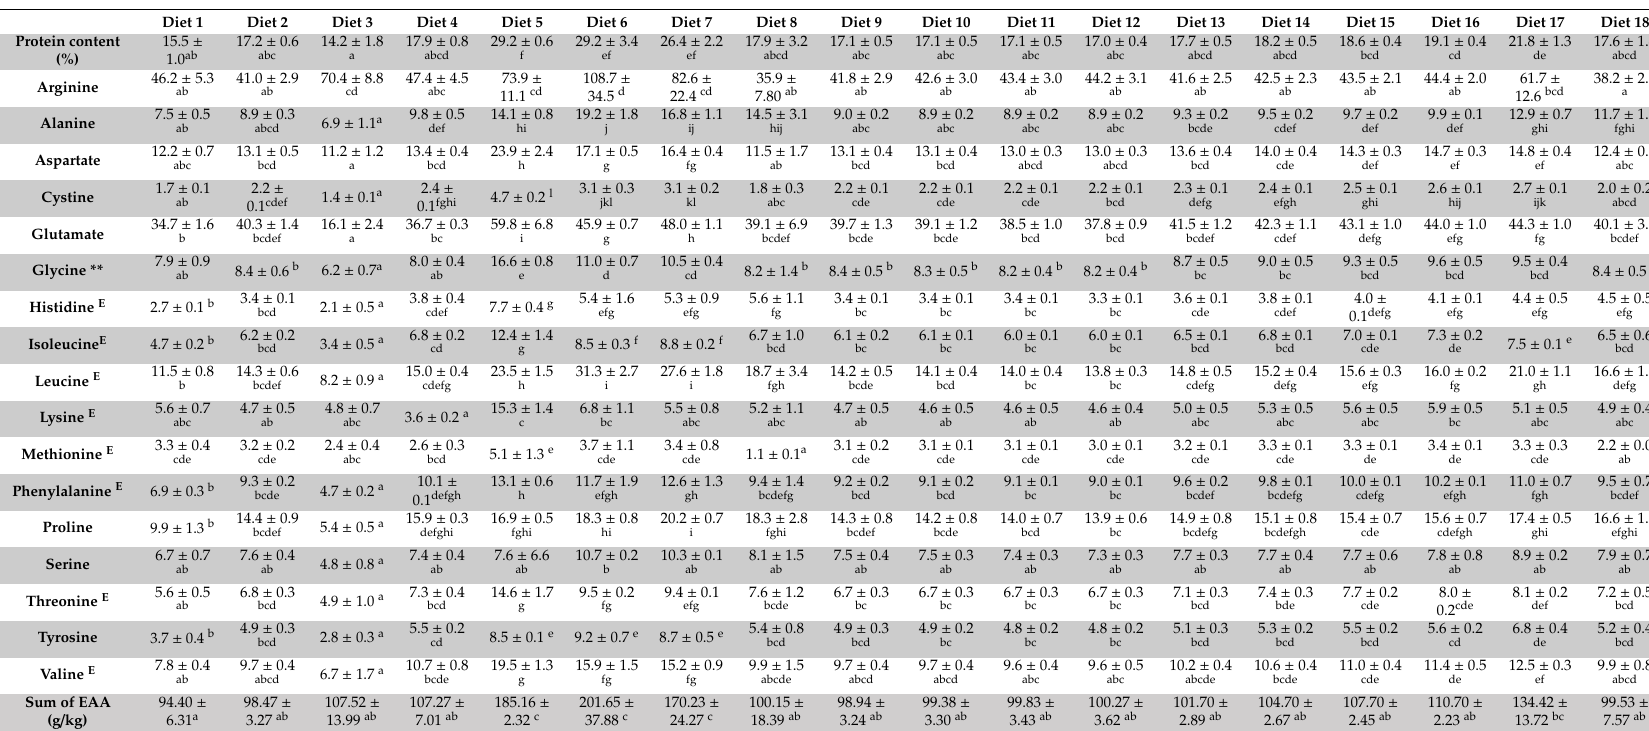
Table A2. Protein content (%), amino acid profile (g / kg) and sum of essential amino acids (g / kg) of the diets on dry matter basis (mean ± SD). E essential amino acids for insects, EAA: essential amino acids, ** ANOVA analysis followed by Tukey post-hoc (letters in superscript), others were analyzed by